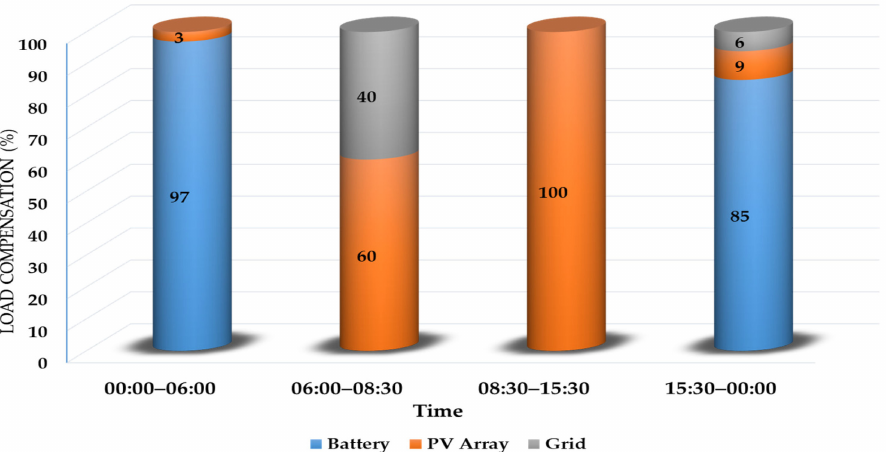
Figure 10. Graphical representation of various electric resources’ contribution towards the DC